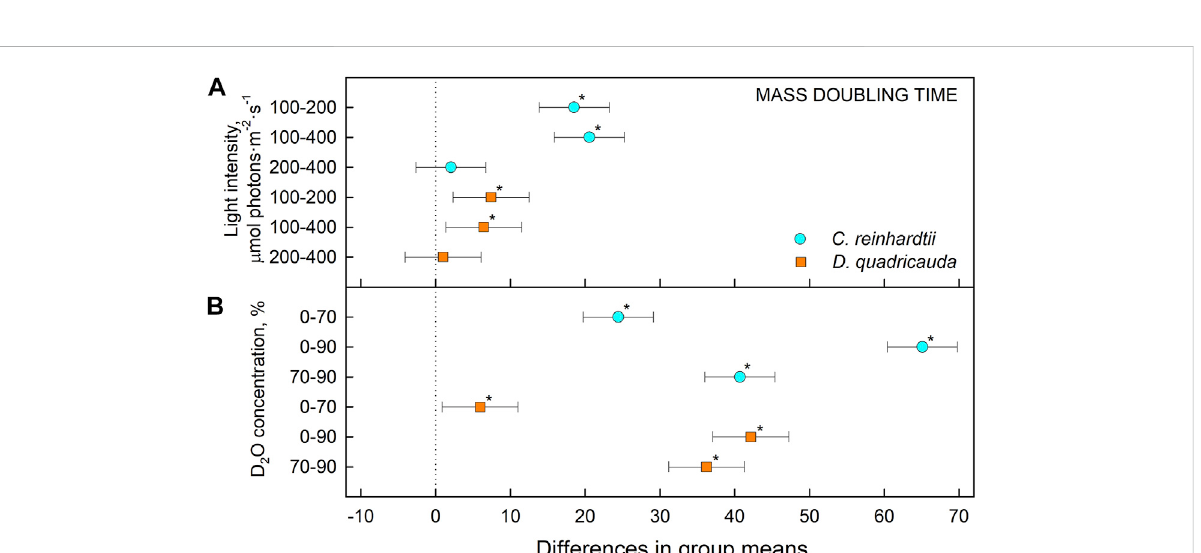
Figure 5 for cell number doubling times. Tukey ’ s HSD test con fi rmed that increasing light intensity from 200 μ mol effect on growth rate (mass doubling time) in D. quadricauda and C. reinhardtii (Figure 4A). D 2 O concentration signi fi cantly affected mass doubling time in all combinations tested, although the difference between 0% D 2 O and 70% D 2 O was the least signi fi cant in D. quadricauda (Figure 4B). In terms of cell number doubling time, only the light intensity of 100 μ mol